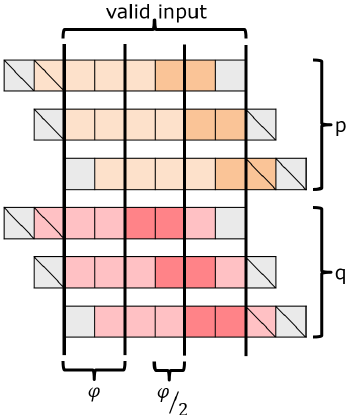
Figure 2. Schematic visualisation of the proposed height change calculation using JSD. The bins of the original histogram of p and q are coloured with orange and red, respectively, where a darker hue indicate higher values. Padded bins are visualised in grey. Bins with a slash are not considered in the JSD